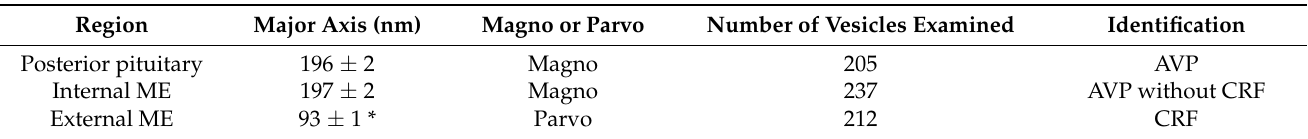
Figure 5. Bee-swarm and box plots displaying the major axis of dense-cored neurosecretory vesicles distributed in the posterior pituitary (black), internal layer of the median eminence (ME) (red), and external layer of the ME (green) in macaque monkeys. The major axis of dense-cored vesicles in the posterior pituitary and the internal layer of the ME (~200 nm) was significantly larger than that of the vesicles in the external layer of the ME (~100 nm). * p < 0.05, vs. posterior pituitary and internal layer of the ME. Table 2. Identification of cell types (magno- or parvocellular neurons) based on the major axis of dense-cored neurosecretory